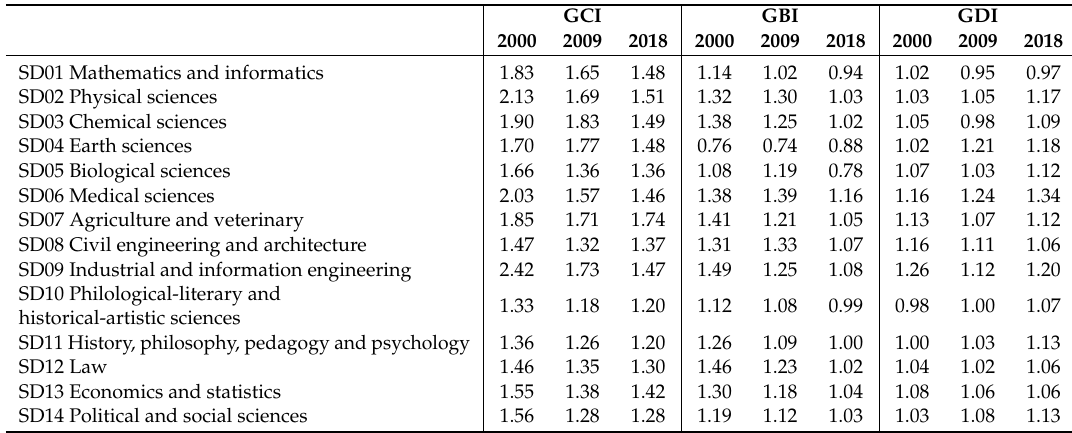
Table 6. Glass Ceiling Index (GCI), Glass Bottleneck Index (GBI), and Glass Door Index (GDI) by scientific field and year,